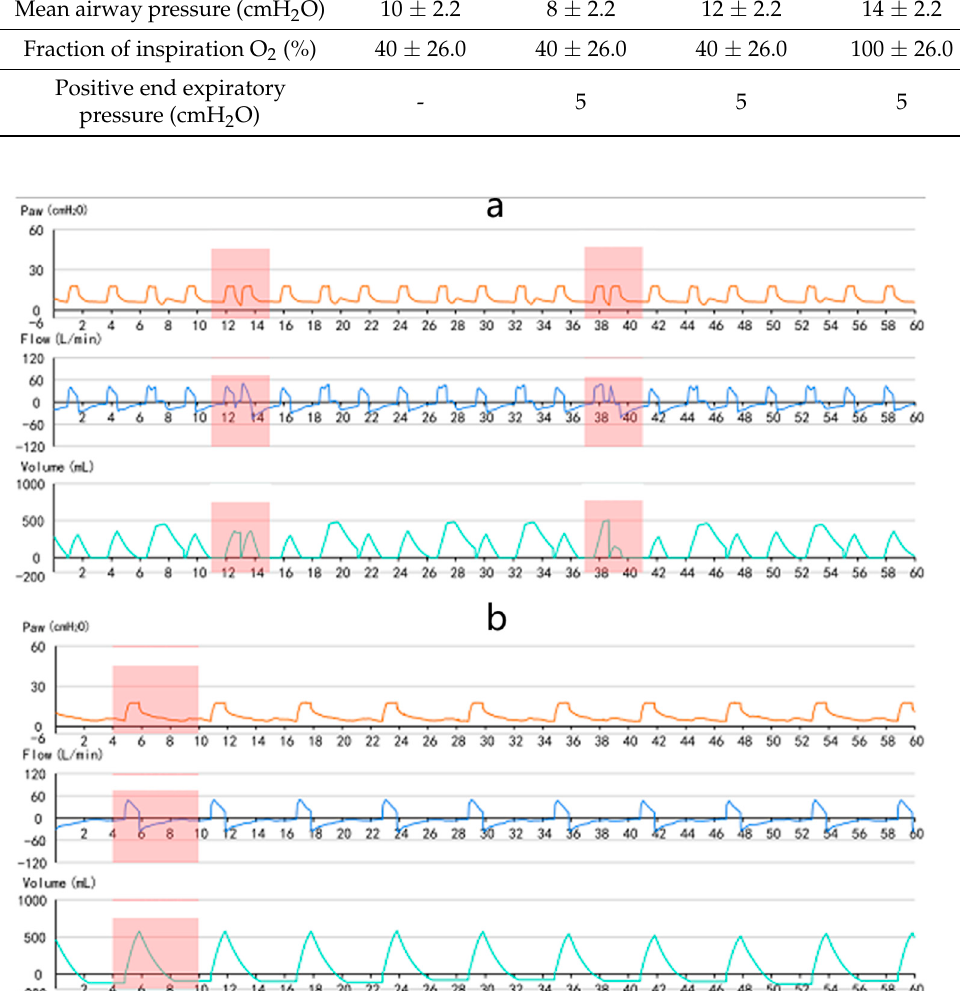
Figure 4. Data abnormal waveform. ( a ) Double triggering waveform. ( b ) Ineffective triggering waveform. Table 2. Experimental results of the double triggering